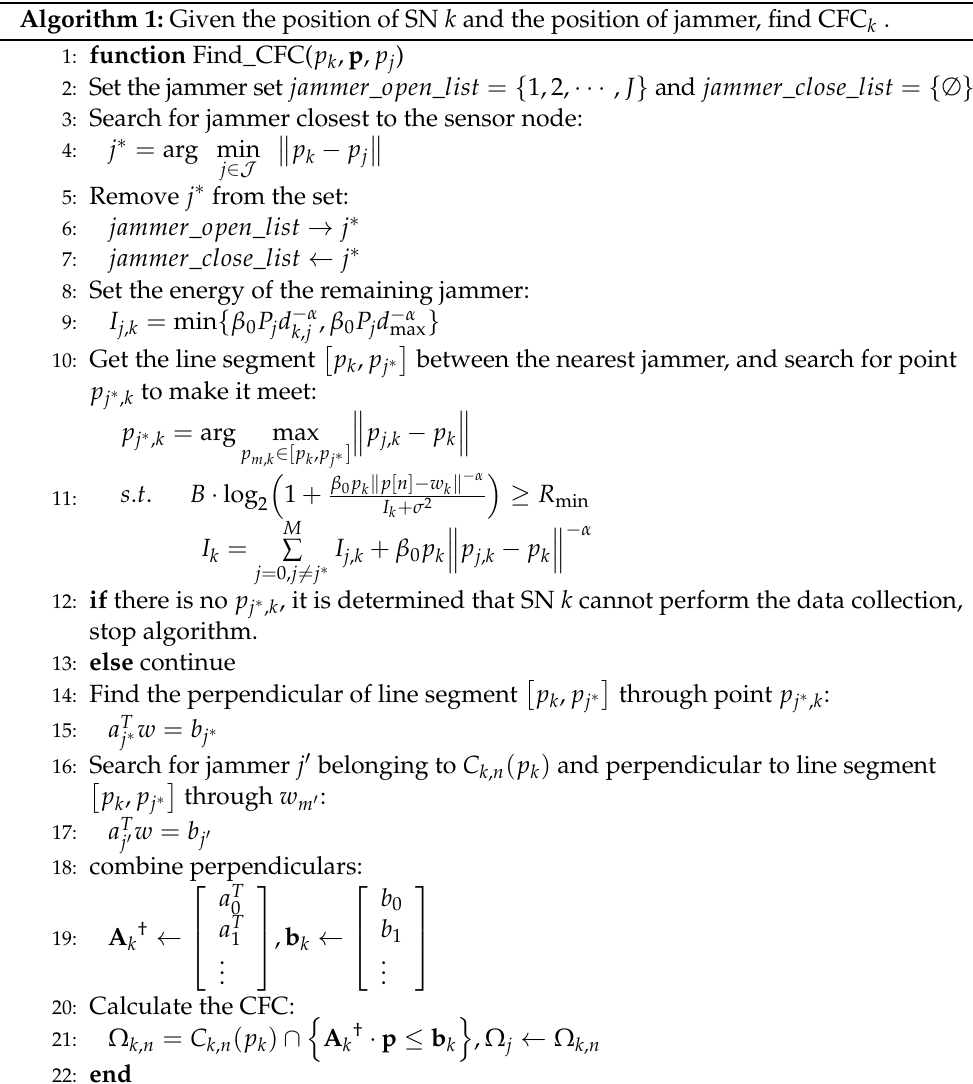
Algorithm 1: Given the position of SN k and the position of jammer, find CFC k